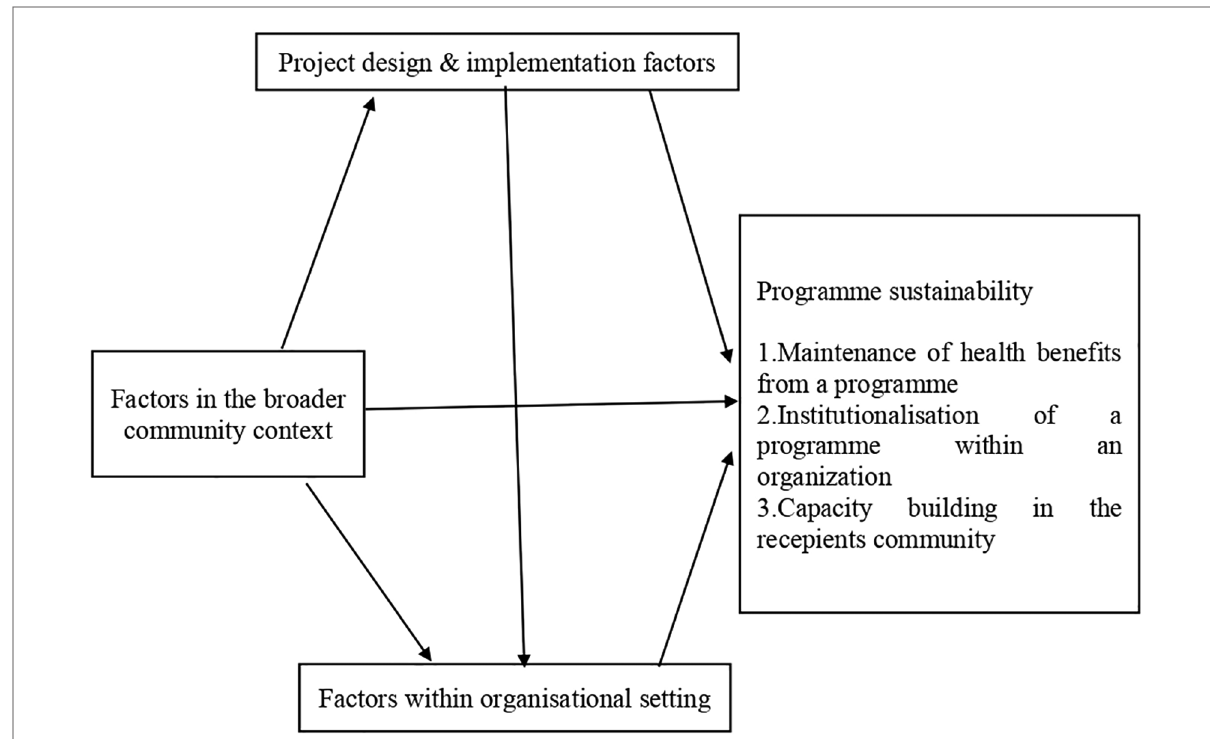
FIGURE 1 Shediac-Rizkallah and bone framework conceptualising programme